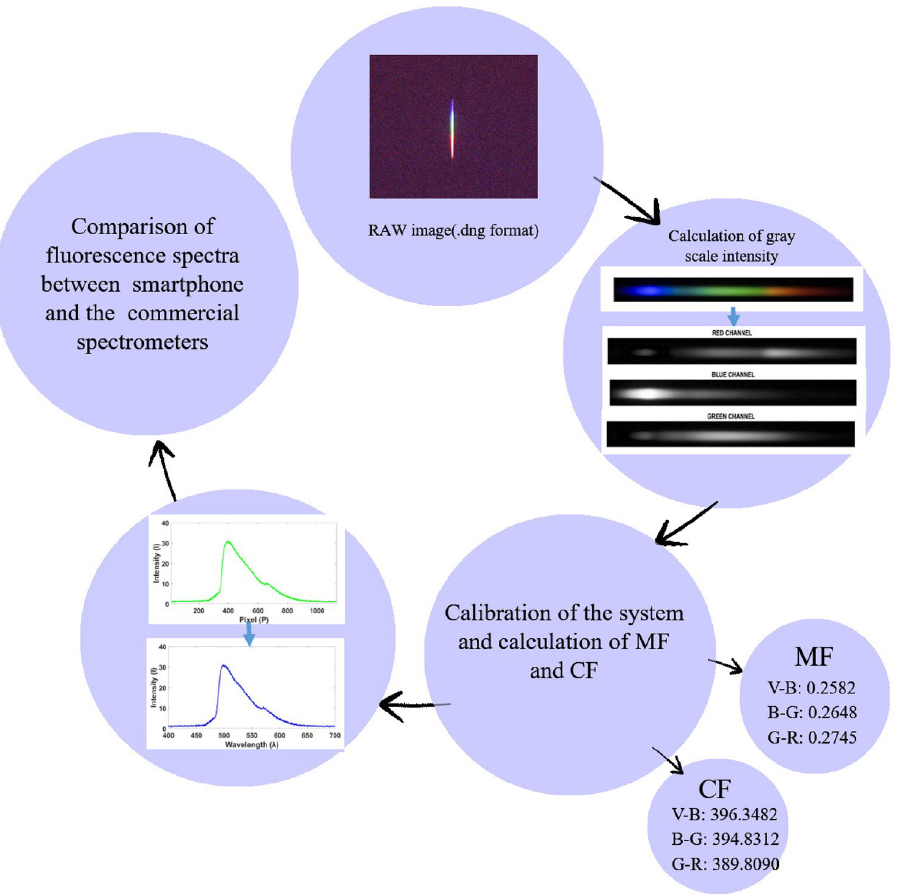
Figure 4. Flow chart explaining pixel to wavelength conversion and calibration